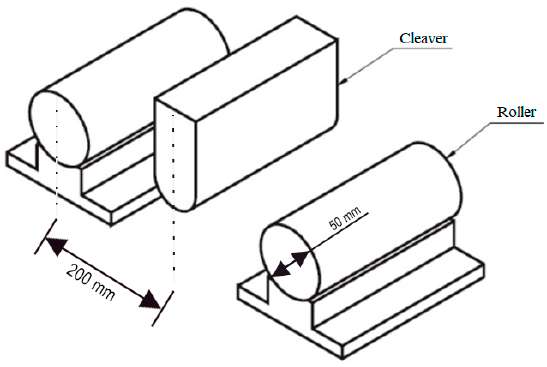
Figure 4. Experiment schematic.